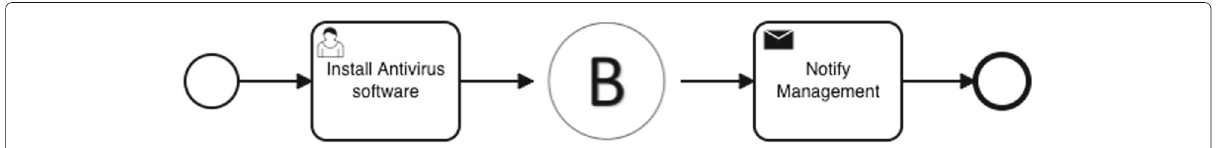
Fig. 11 Anti-virus installation process with BoP